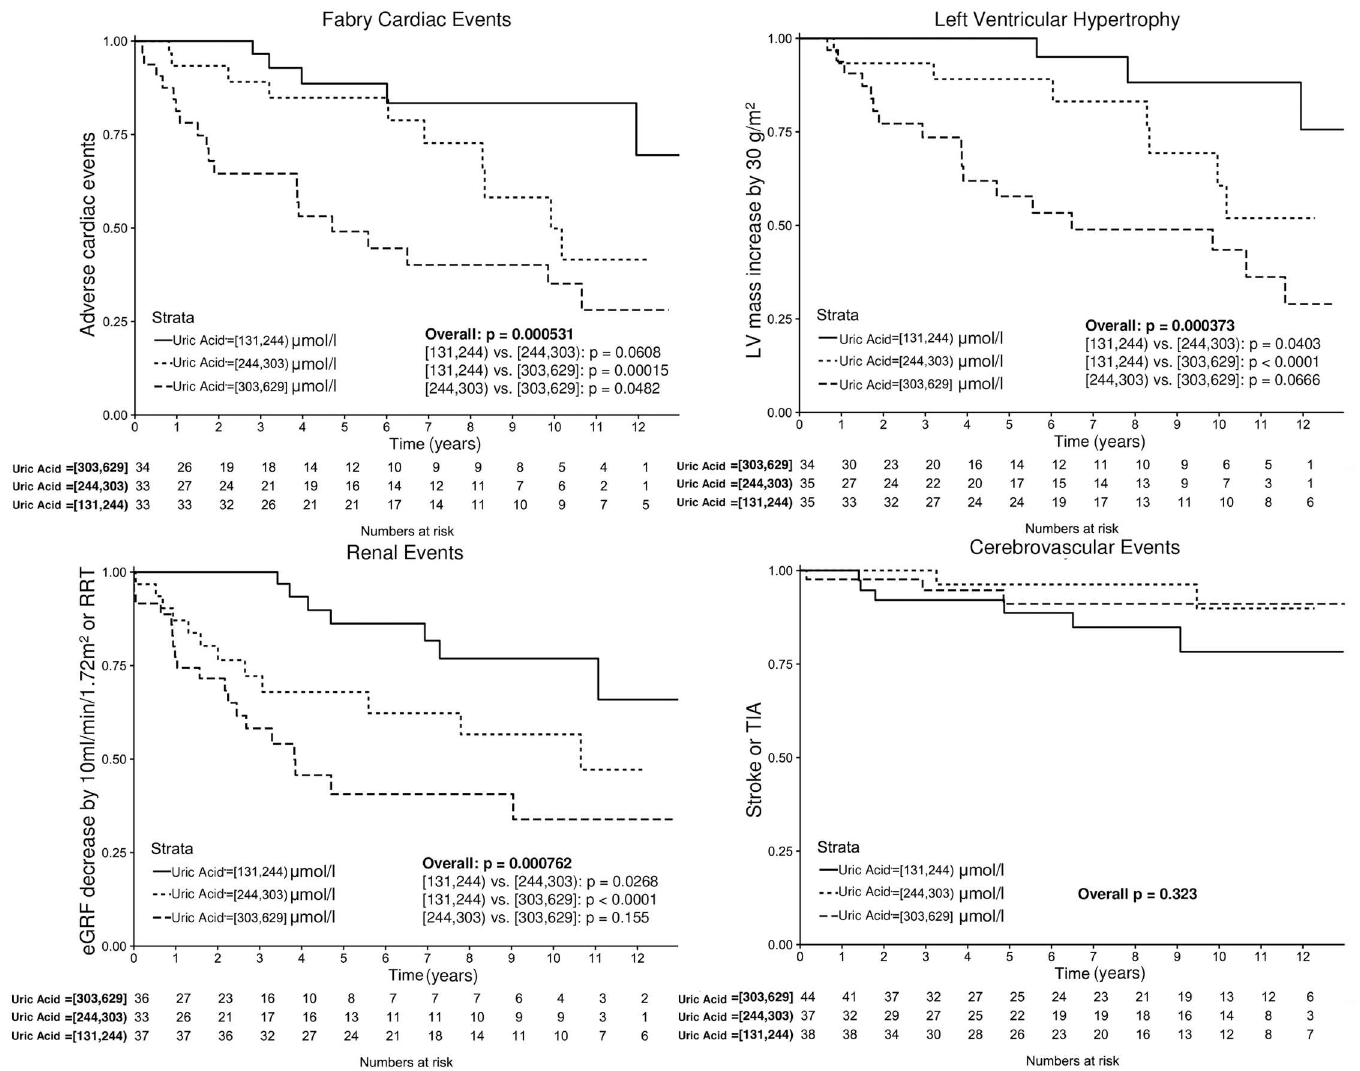
Fig 3. Kaplan-Meier analysis according to tertiles of UA for A) Fabry cardiac events B) progression of left ventricular hypertrophy C) renal events (p < 0.001 for all), and D) cerebrovascular events where no significant association was observed (p = 0.323).